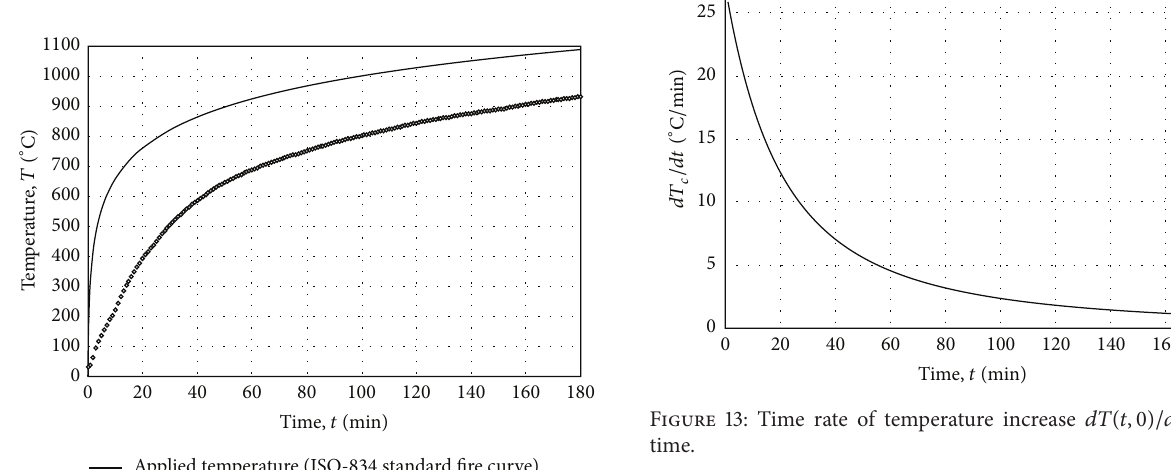
Figure 10: Comparison of thermal conductivity 𝑘 (concrete brick testing), and 𝑘 method), 𝑘 CB practice), respectively.